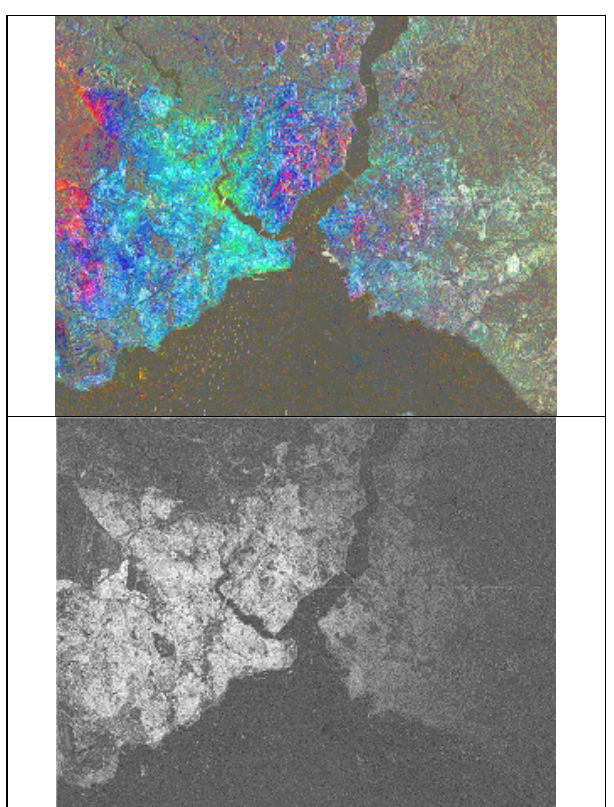
Figure 6.b. Filtered interferogram and coherence map –